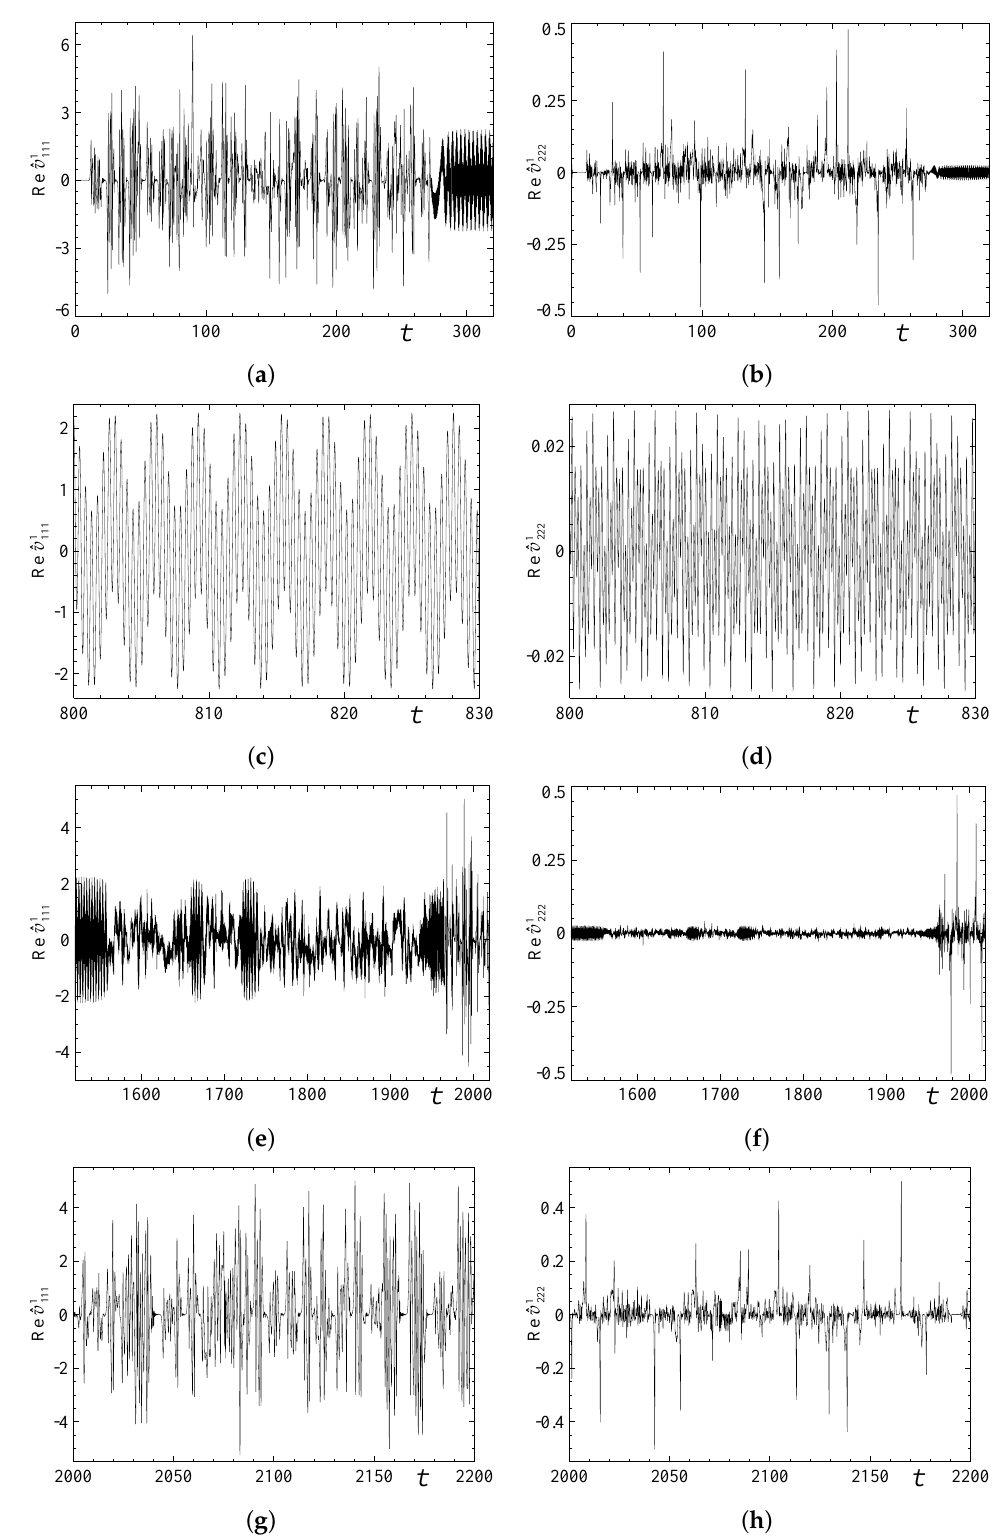
Figure 7. Temporal behaviour of the Fourier coefficients Re ˆ v 1 column) in run 2 x 1.2 in four time intervals: 0 ≤ t ≤ 320 (phase T of the initial transient processes, chaotic behaviour and approach to the quasiperiodic metastable state), (a), (b); 800 ≤ t ≤ 830 (phase G in the vicinity of the quasiperiodic hydrodynamic metastable state), (c), (d); 1520 ≤ t ≤ 2020 (departure from phase G, phase S of the saturated chaotic regime and approach to the chaotic phase D), (e), (f); and 2000 ≤ t ≤ 2200 (phase D of magnetic field decay), (g),